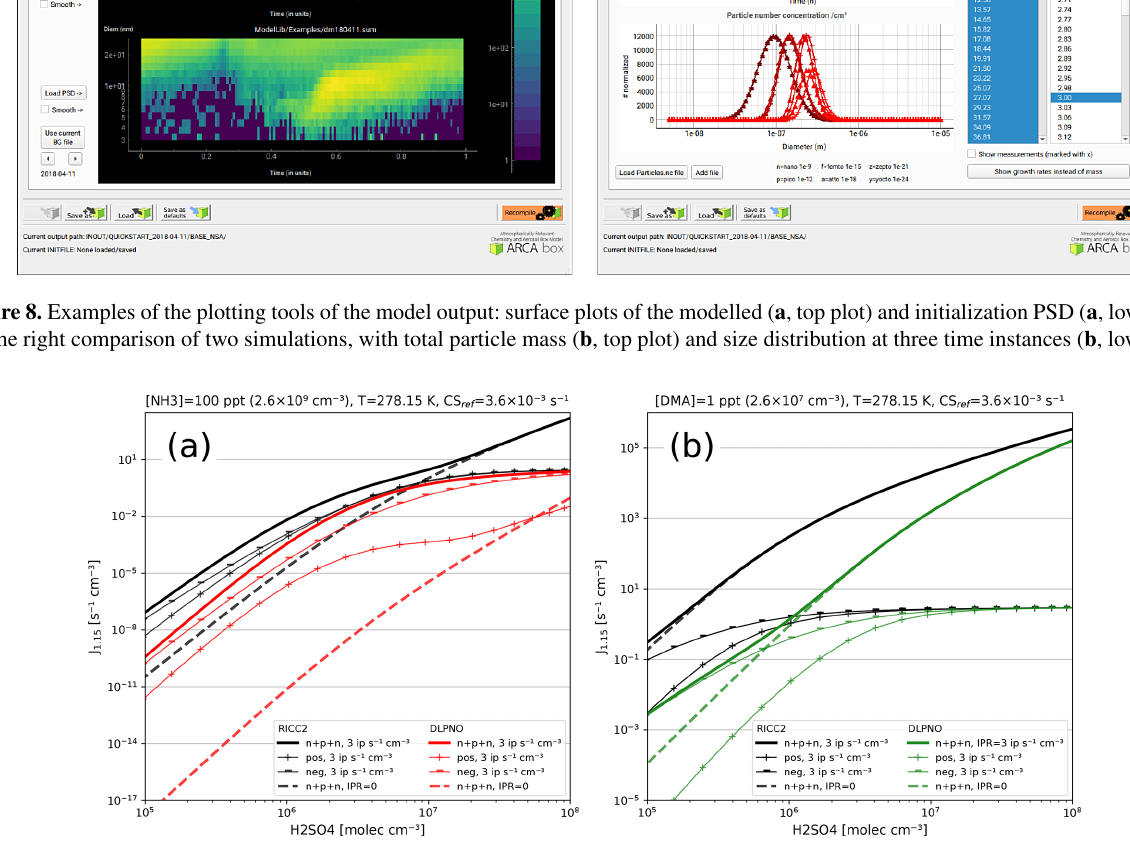
Figure 9. Steady-state particle formation rates from the two H 2 SO 4 –NH 3 (a) and two H 2 SO 4 –DMA systems (b) . Both chemistries include data from RICC2 and DLPNO level of theories. Thick lines show the total formation rate, and solid lines are in the presence of ions and dashed lines without ions present. All simulations used the same temperature (5 ◦ C) and external cluster losses (3 . 6 × 10 − 3 s − 1